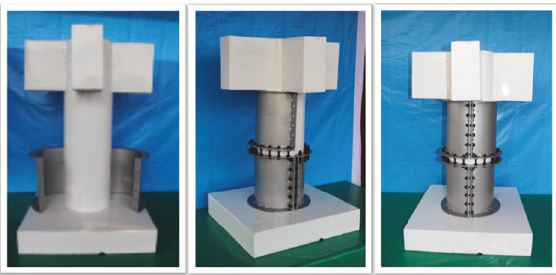
Figure 3: The model of prestressed reinforcement column.